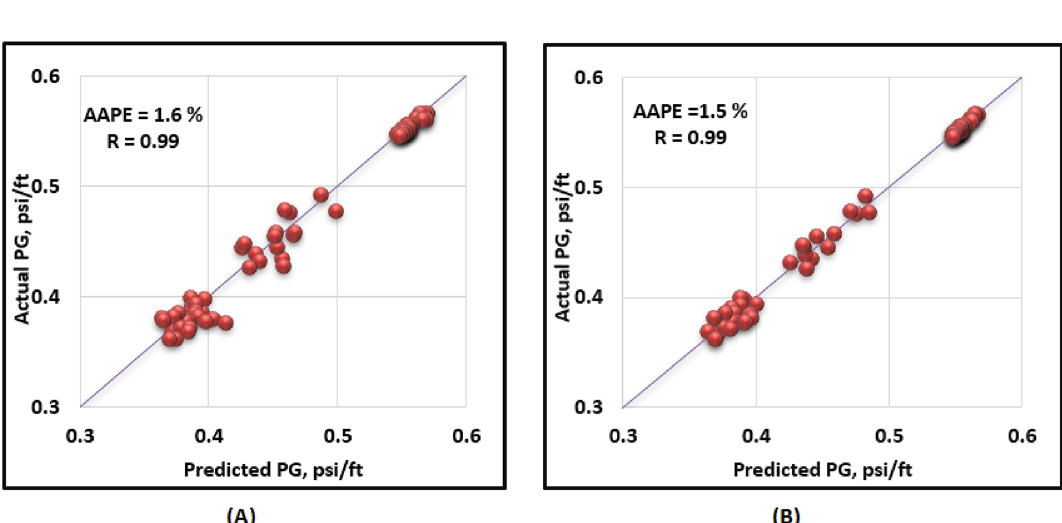
Figure 11. Cross-plots for validation stage ( A ) ANN, and ( B )